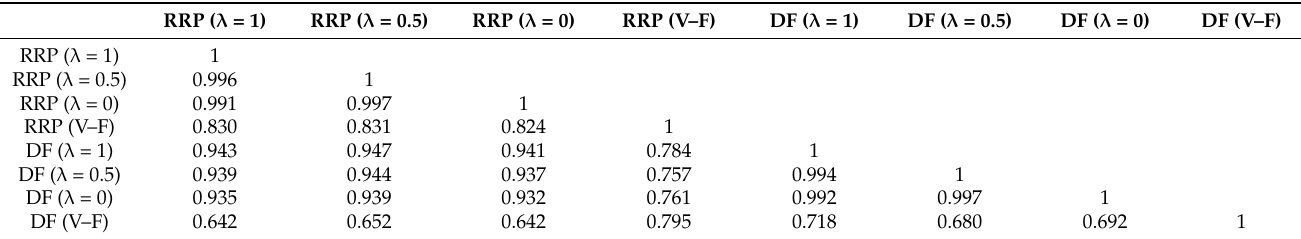
Table 10b. Spearman correlations between the expected values of RRP and/or DF for several values of the index of optimism λ